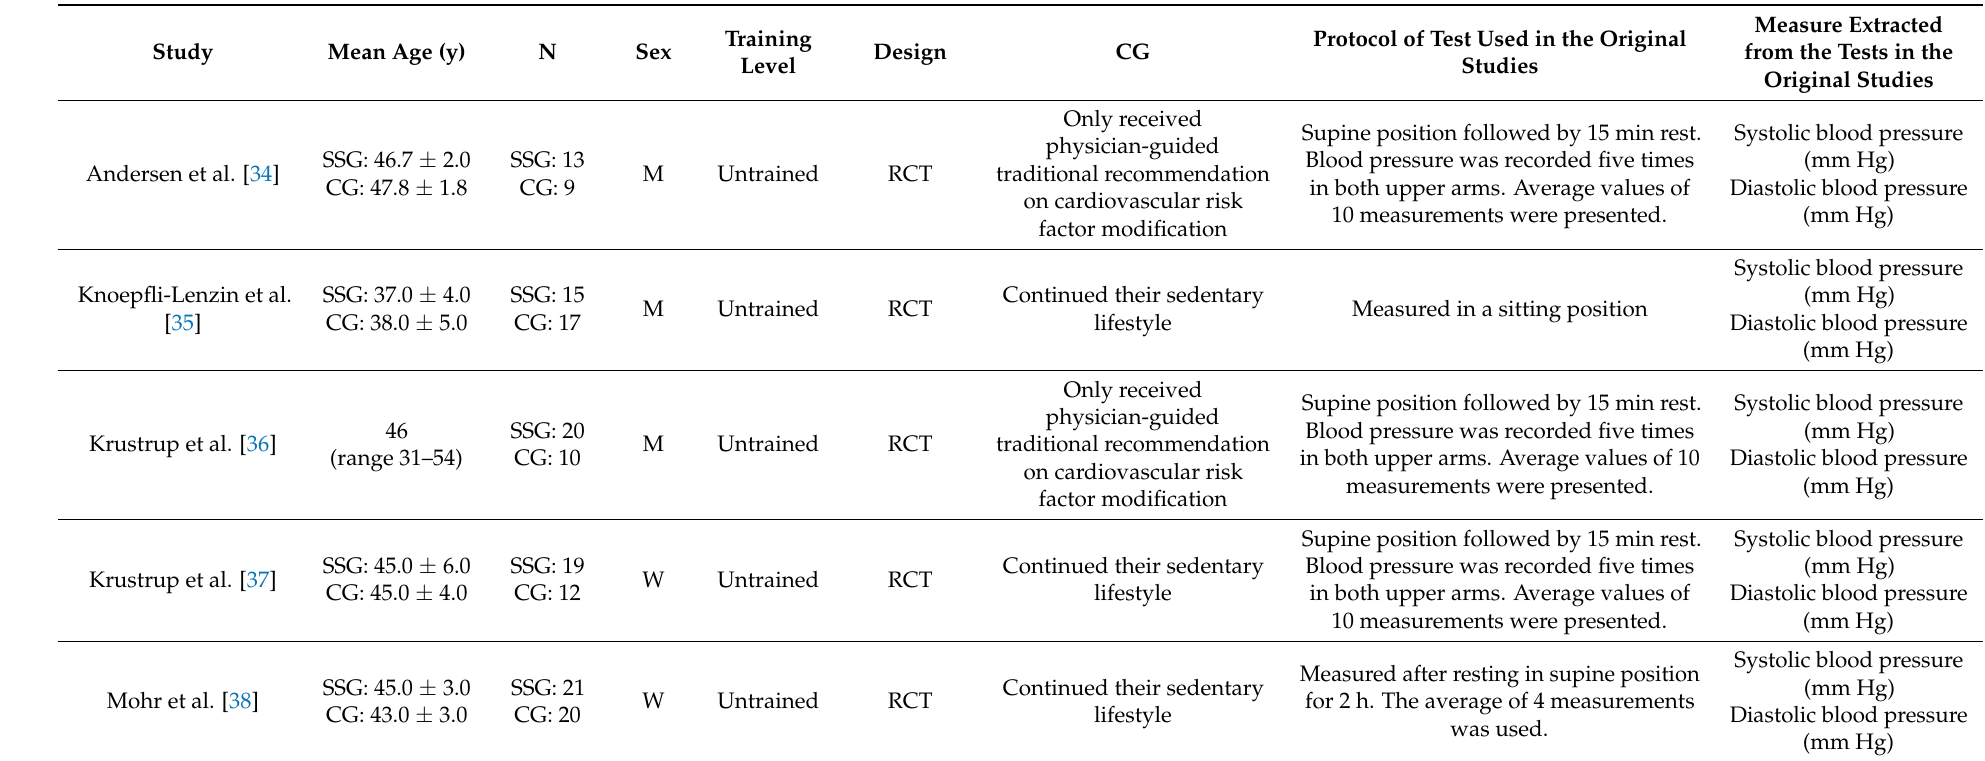
Table 2. Characteristics of the included studies and outcomes